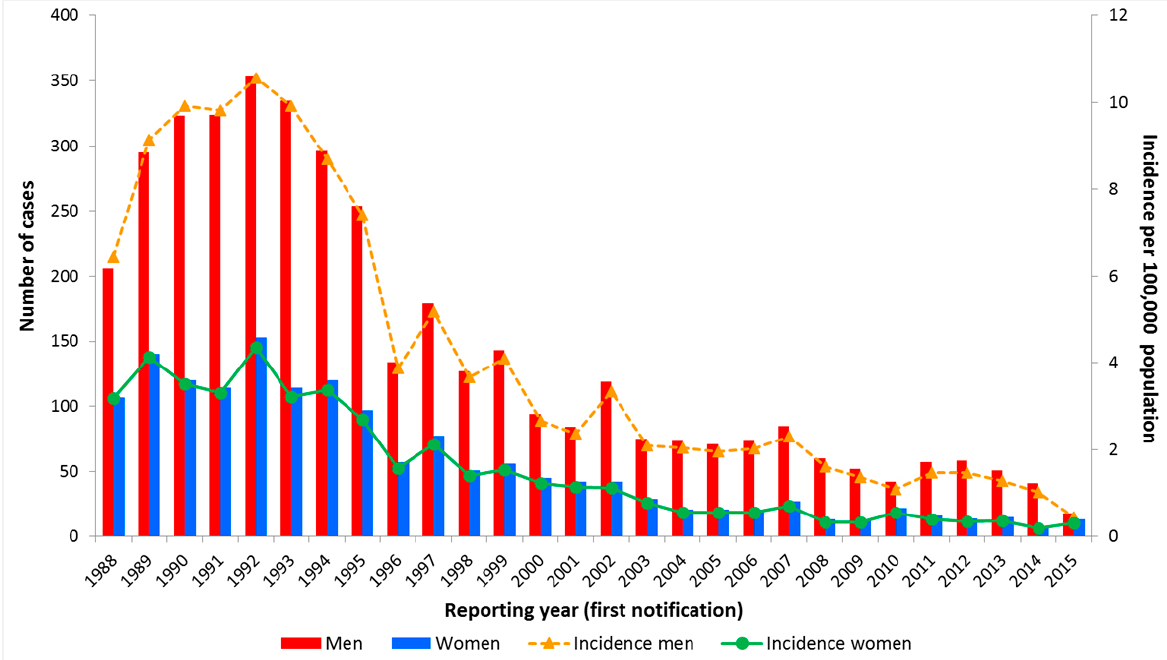
Figure 2: Notified acute hepatitis B virus infection with annual incidence rates by sex, Switzerland,